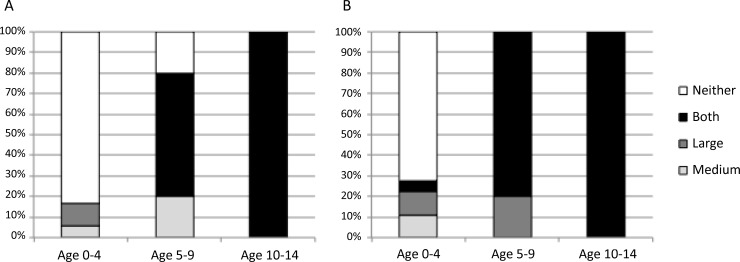
Comparison of the standard and large Vivio heads.Successful capture of carotid artery waveform as broken down by ages 0–4, 5–9, and 10–14 years as determined by (A) computer algorithm alone and (B) with additional manual review by IF expert.